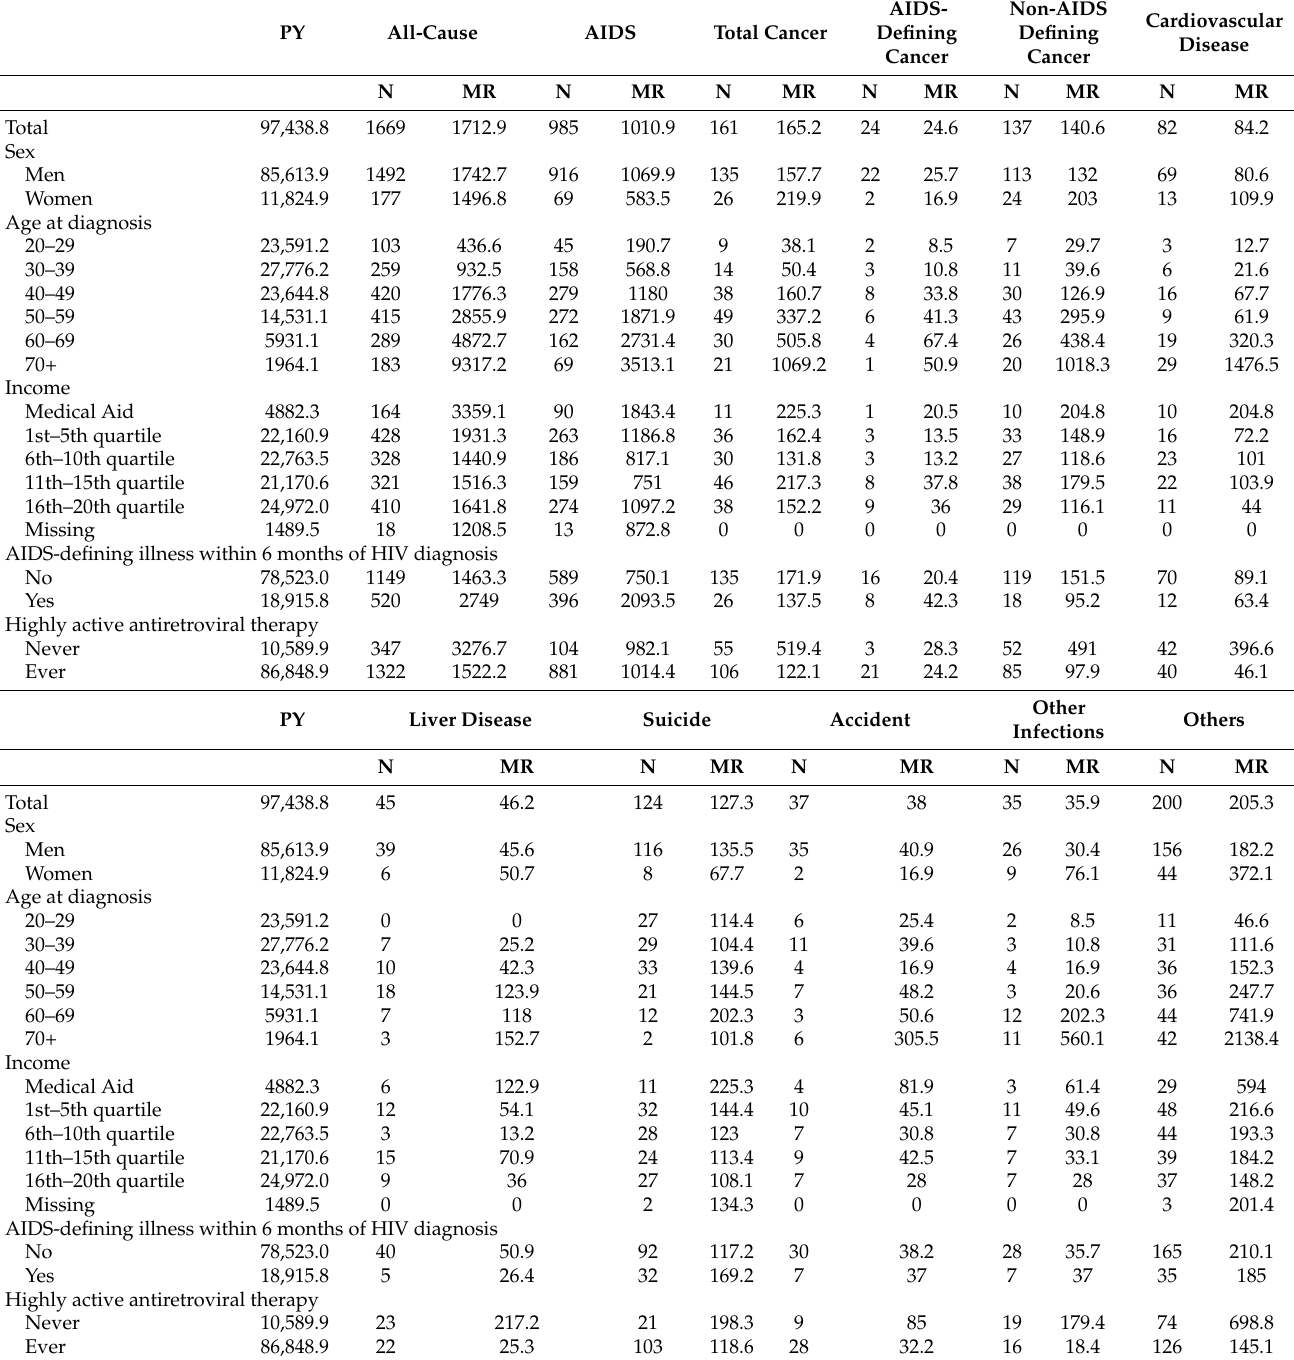
Table 2. Mortality according to characteristics of human immunodeficiency virus (HIV)-infected individuals in Korea, 2004–2018: all-cause mortality, and mortality from acquired immunodeficiency syndrome (AIDS), cancer, AIDS-defining cancer, non-AIDS defining cancer, cardiovascular disease, liver disease, suicide, accident, other infections, and other